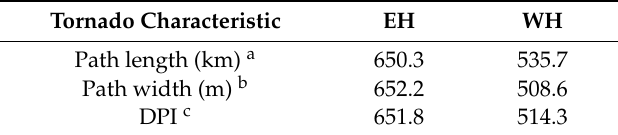
Table 12. Mean ranks used in the Mann-Whitney tests for the east half (EH) and west half (WH). Results of the Mann-Whitney tests are located below the